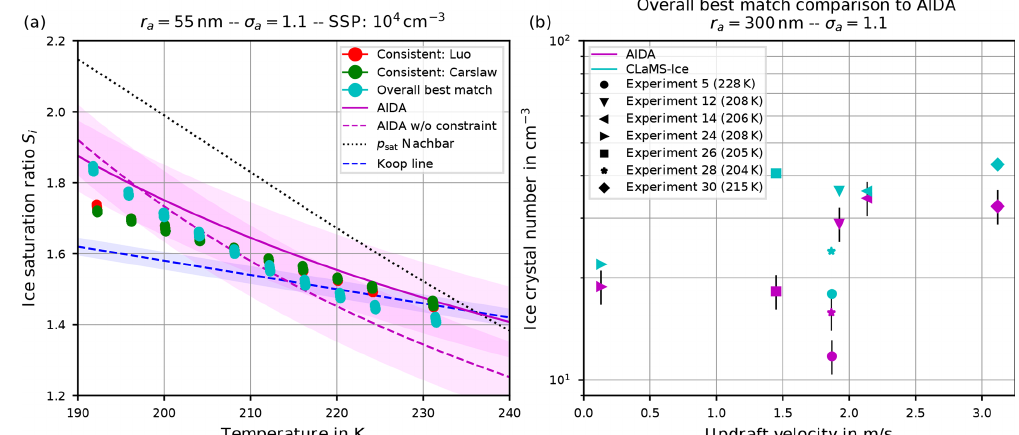
Figure 14. (a) Ice onset humidities as a function of temperature and (b) number of nucleated ice crystals versus vertical updraft. Magenta colors: observations at the AIDA cloud chamber ( a , dashed line: fit line through observational results for sulfuric acid solution particles; solid line: fit line crossing water saturation at 235K; shaded regions: uncertainties of ± 0 . 1 around fit lines; b , symbols: experiments per- formed during the campaign TROPIC02; see Schneider et al., 2021), together with the observed ice onset temperature per experiment. Cyan symbols: CLaMS-Ice simulations’ “overall best match” with AIDA observations, achieved by combining the water vapor saturation param- eterization p sat from Nachbar et al. (2019) with Carslaw’s water activity a w for ice nucleation and Luo’s a w for aerosol growth (Köhler equilibrium). Red and green dots: CLaMS-Ice simulations’ “consistent” setups, i.e., Nachbar’s p sat and either Luo’s (red dots) or Carslaw’s (green dots) a w for both ice nucleation and aerosol